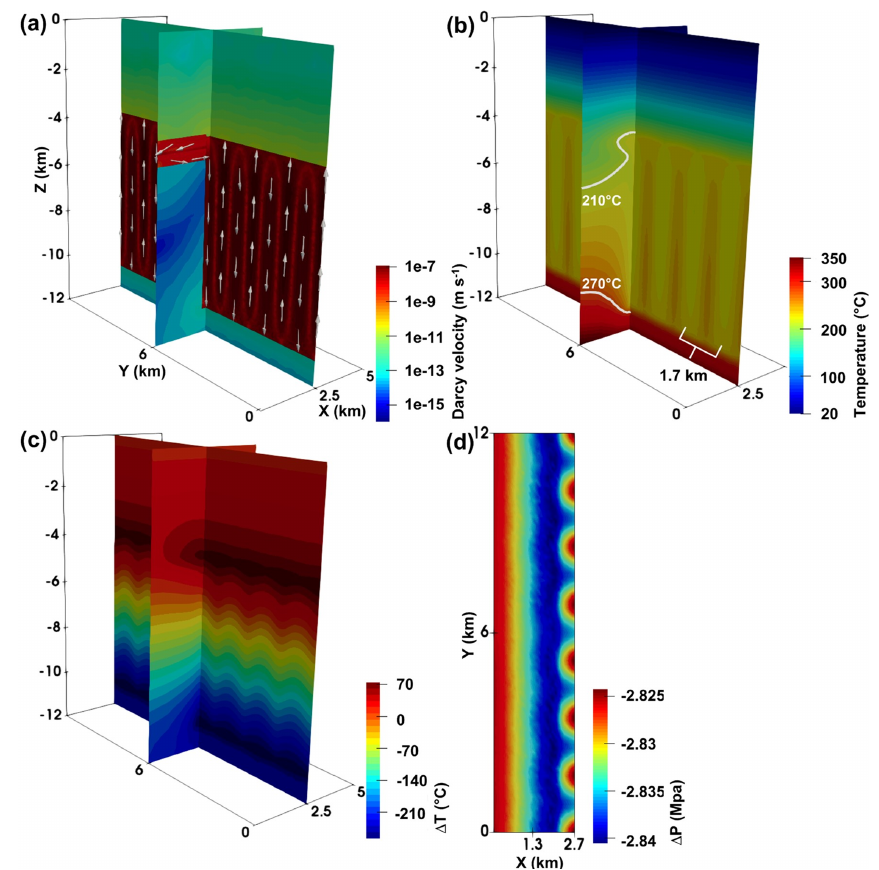
Figure 8. Fluid-flow, temperature and pore-pressure change fields of the κ SST = 10 − 14 case at 1Myr. Cross-sectional view of the (a) flow field with arrows representing the preferential fluid-flow pathways and (b) resulting temperature field. The 210 and 270 ◦ C isotherms are highlighted to indicate the dominant heat-transfer types. Panel (c) shows the temperature differences compared to the initial conductive tem- perature distribution. Panel (d) shows the top view of the pore-pressure change compared to the initial hydrostatic pore pressure (43.3MPa) in the western sandstone, transfer faults and main fault at a depth of 4.4km. The 1.3 and 2.7km along the x axis follow the western boundary of the Piesberg quarry and the eastern boundary of the main fault,